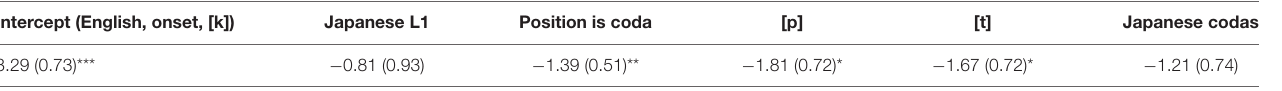
TABLE 5 | Logistic regression coefficients (log-odds change, with standard error in parentheses) for the audio-only model. Intercept (English, onset,